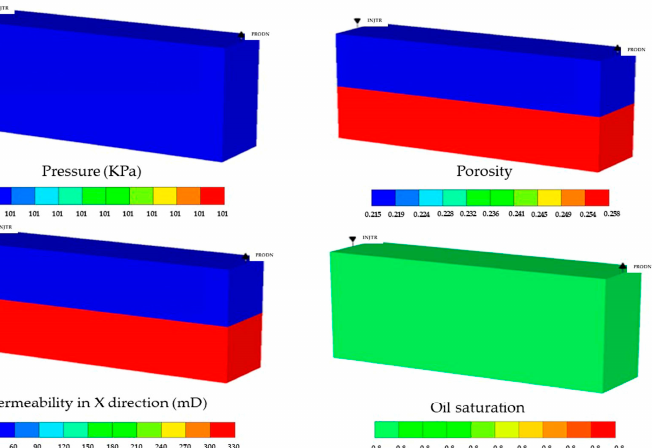
Figure 6. The distribution of initial pressure, porosity, permeability, and oil saturation in the gel flooding experimental model.